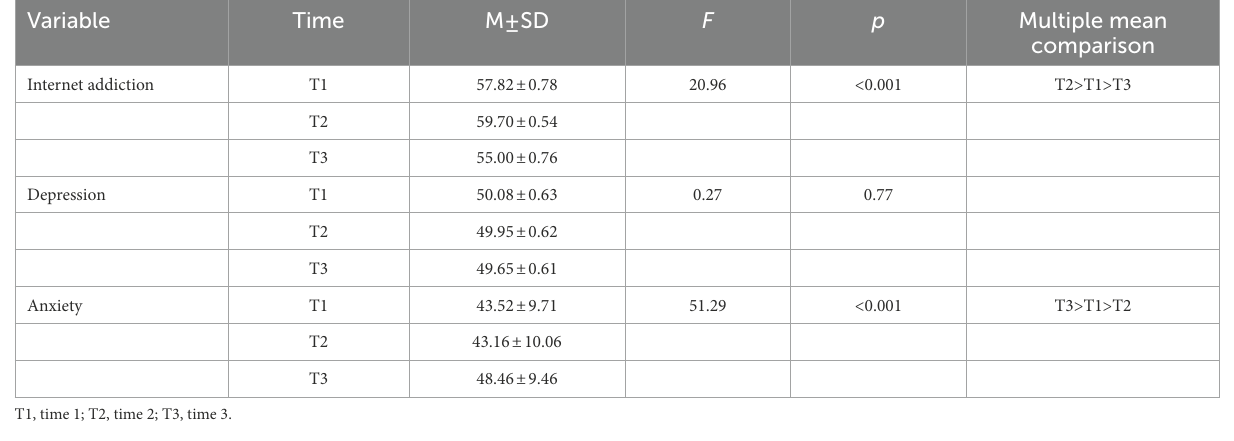
TABLE 4 ANOVA test of variables at different time points.